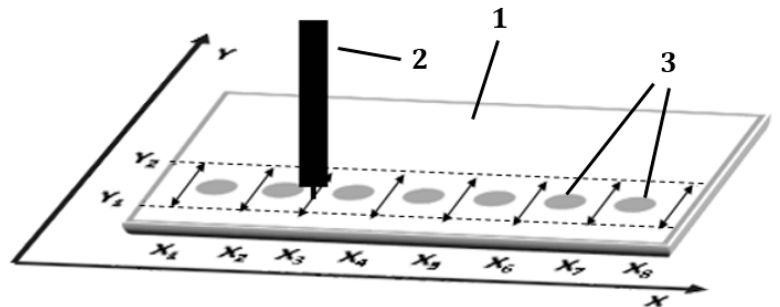
Figure 7. Scheme of the moving pipette paths represented by double-sided arrows for the narrowing procedure of the sample spots applied on the start line. 1—chromatography plate; 2—moving pipette; 3—sample spots applied on the chromatographic plate.